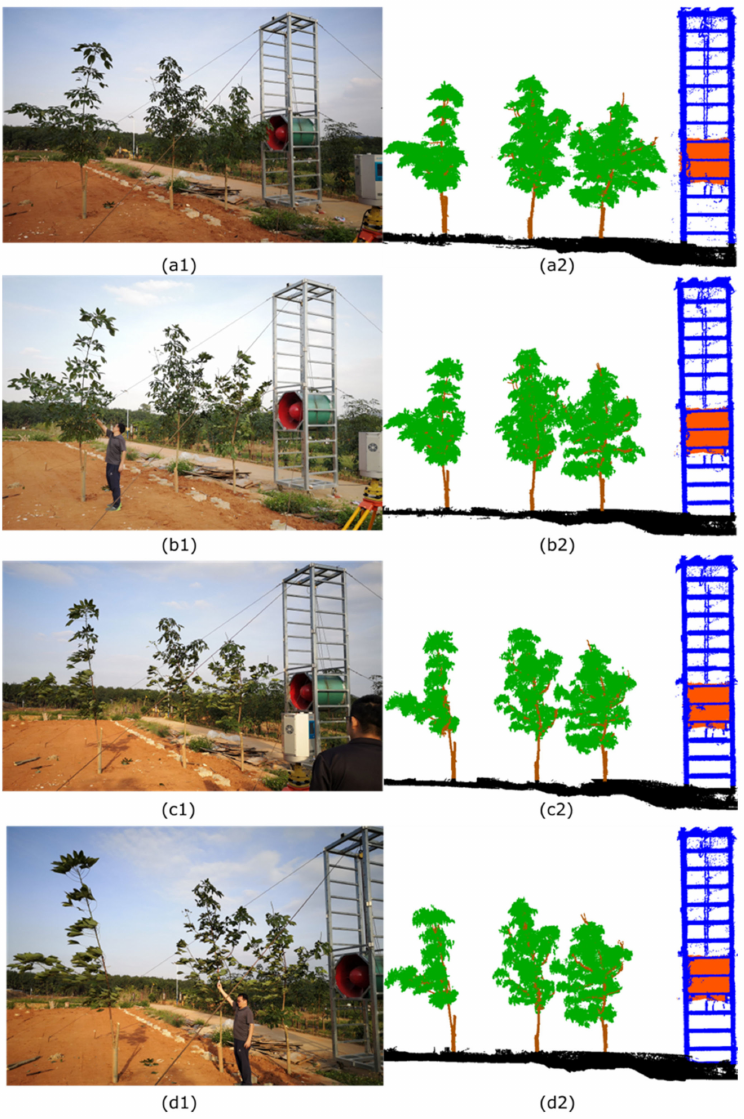
Figure 4. Photos (left) of the field experiment simulating the effects of a strong air current on trees under different wind speeds and point cloud data (right) after the wood–leaf classification under different wind speeds. The emitted wind speeds of the fan from ( a1 – d2 ) are 0 m/s, 10.5 m/s, 13.5 m/s, and 17.5 m/s,